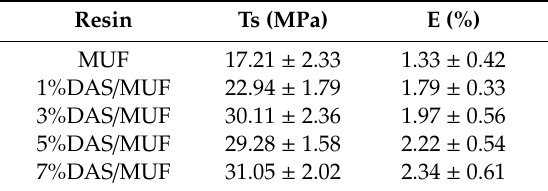
Figure 10. In situ polymerization and microphase separation structure in DAS-modified MUF resin.